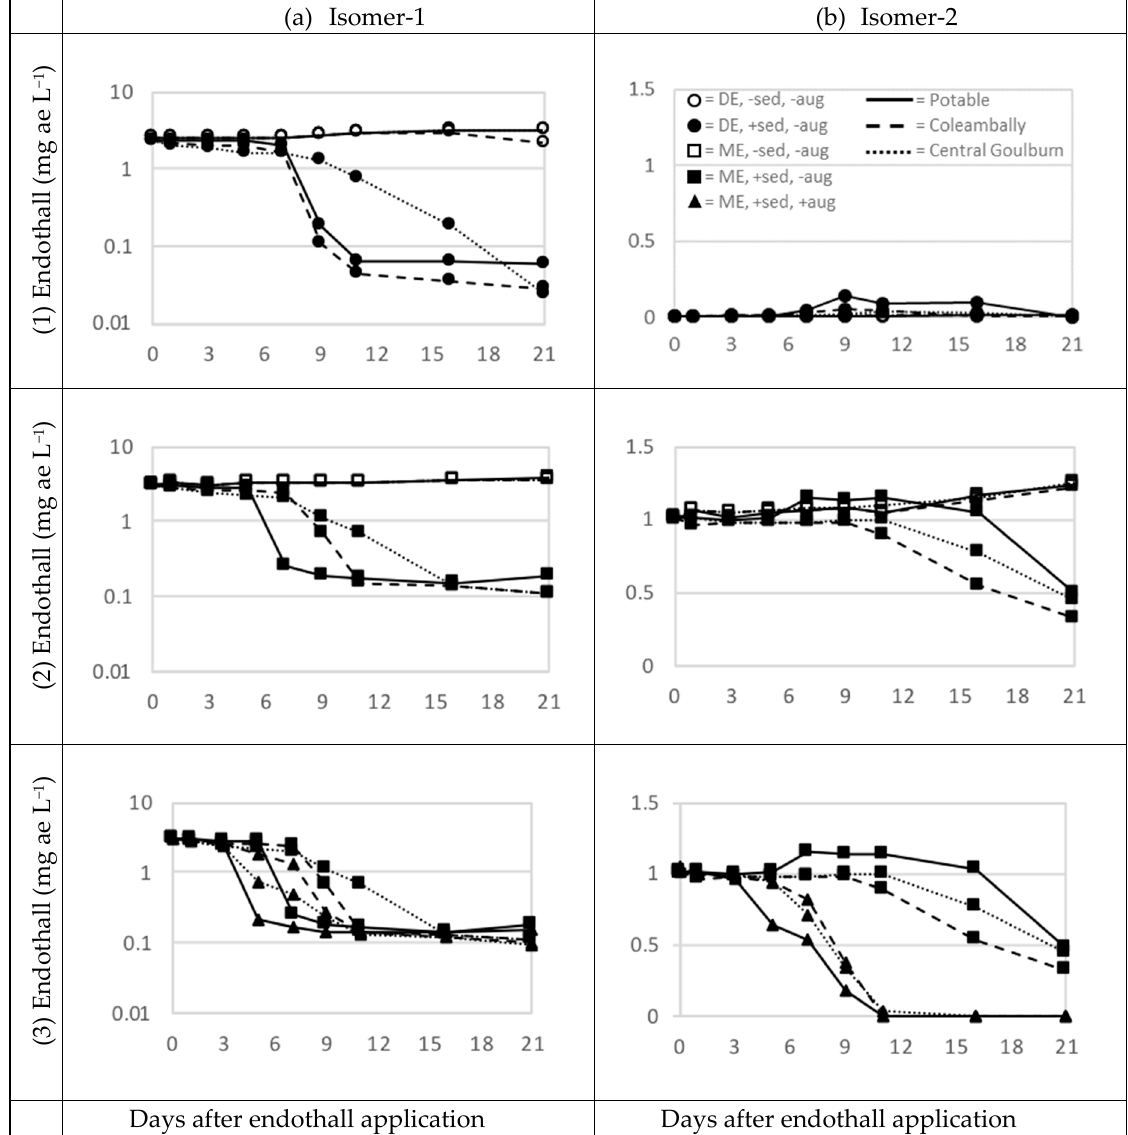
Figure 2. Endothall isomer-1 ( a ) and isomer-2 ( b ) concentrations in mesocosms for each treatment. Values represent average over three replicates. Plots represent various combinations of endothall formulation, source of water and sediment, presence or absence of sediment, and microbe augmentation. Note different y-axis scales between left and right panels. (1) Treatments containing dipotassium endothall without microbe augmentation. (2) Treatments containing monoamine endothall (without microbe augmentation). (3) Treatments containing monoamine endothall with sediment, +/ − microbe augmentation. Note: a subset of treatments is shown in both (2) and (3). Legend provided in top right panel: Water sources represented by line style; endothall form (DE = Dipotassium endothall, ME = Monoamine endothall), sediment presence or absence (+/ − sed) and pre-exposure to endothall (+/ − aug), represented by shape and full of symbols.